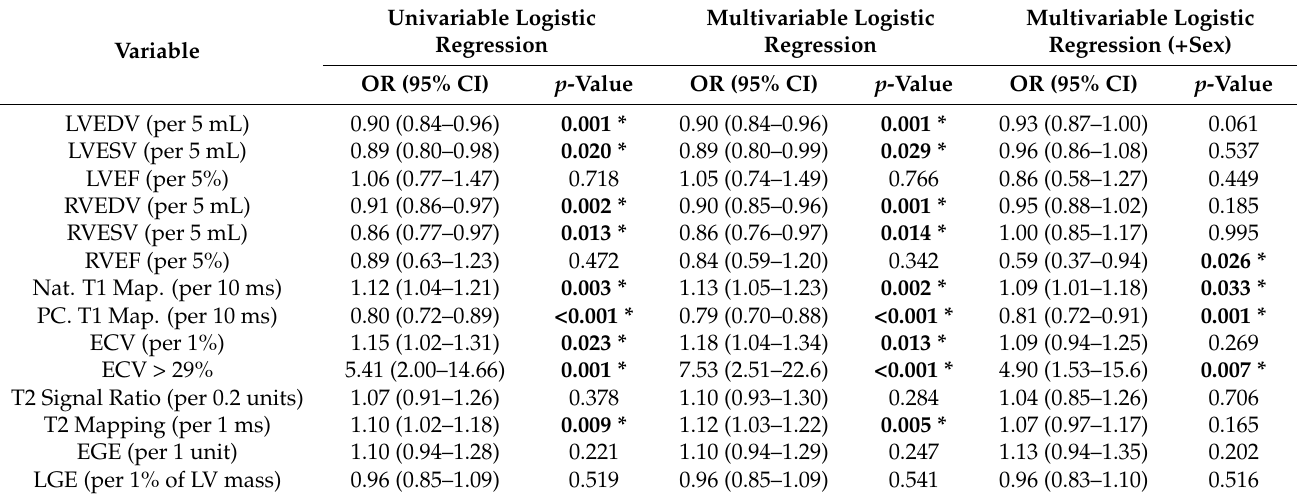
Table 3. Logistic regression analyses for discriminating between ARD and non-ARD patients with NSVT (odds ratio > 1 means higher values more likely in patients with ARDs). All available CMR variables were individually examined and subsequently corrected first for age, hypertension, smoking, family history of CAD/CVD and hypercholesterolemia and subsequently for the same variables but with the addition of sex. * p ≤